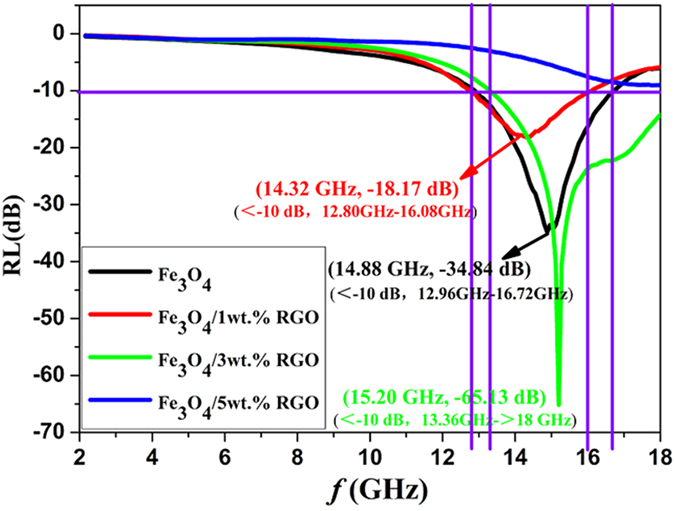
The bandwidths of the composites of 1.7 mm with different ratio between Fe3O4 and RGO.